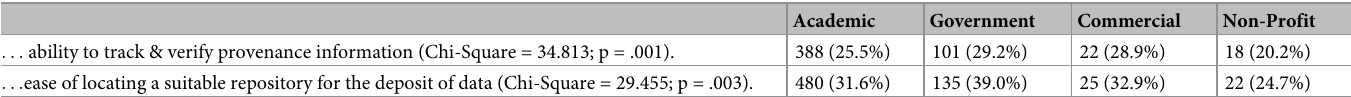
Table 6. Crosstab between “Primary sector of employment” and “Satisfaction with tools for metadata, provenance information and